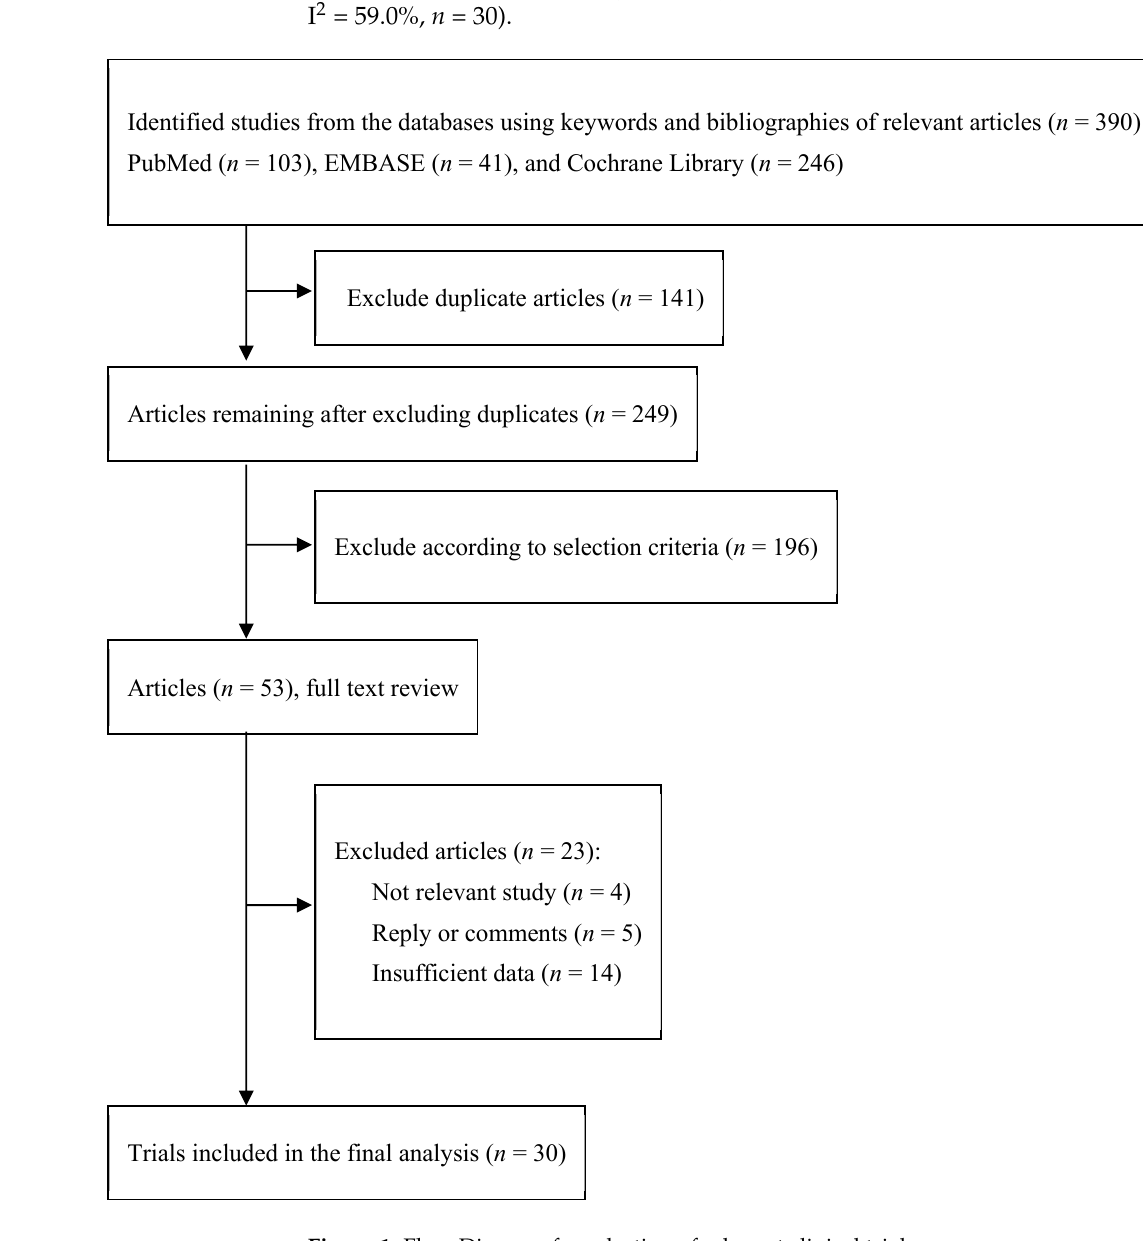
Figure 1. Flow Diagram for selection of relevant clinical trials.